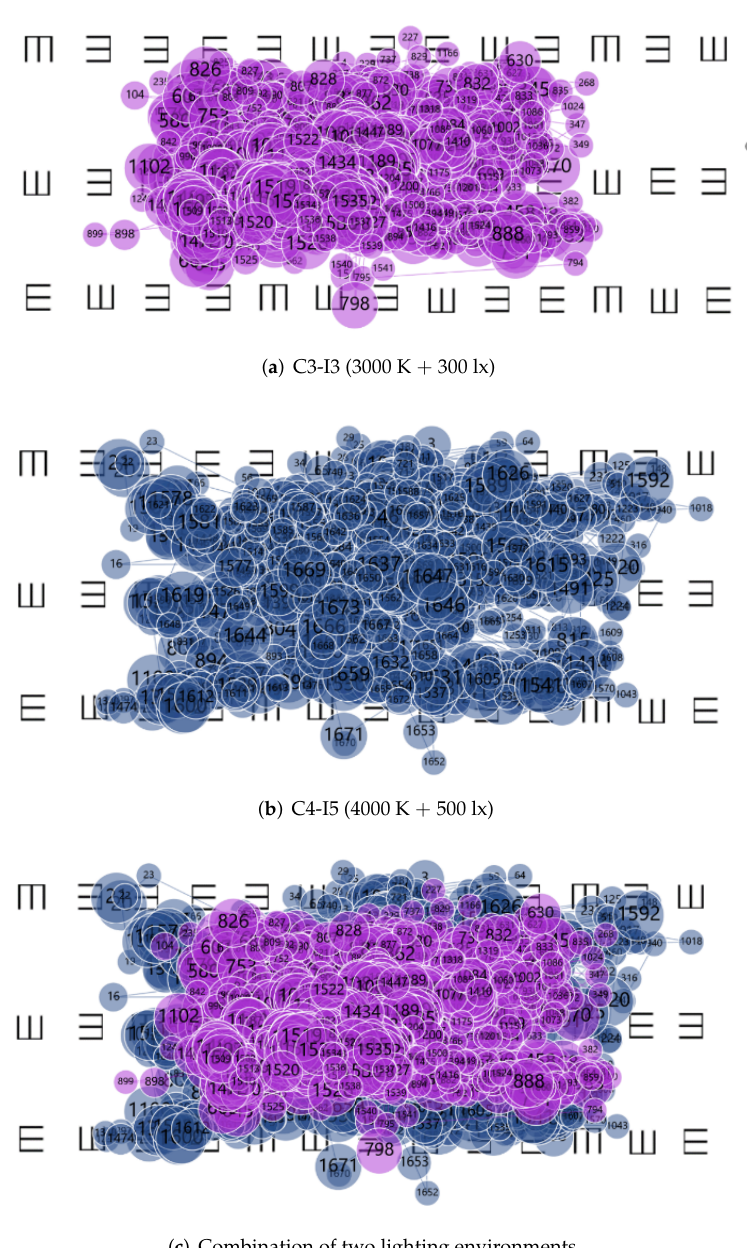
Figure 12. Fixation Point Trajectory Diagram for test 2 under different lighting